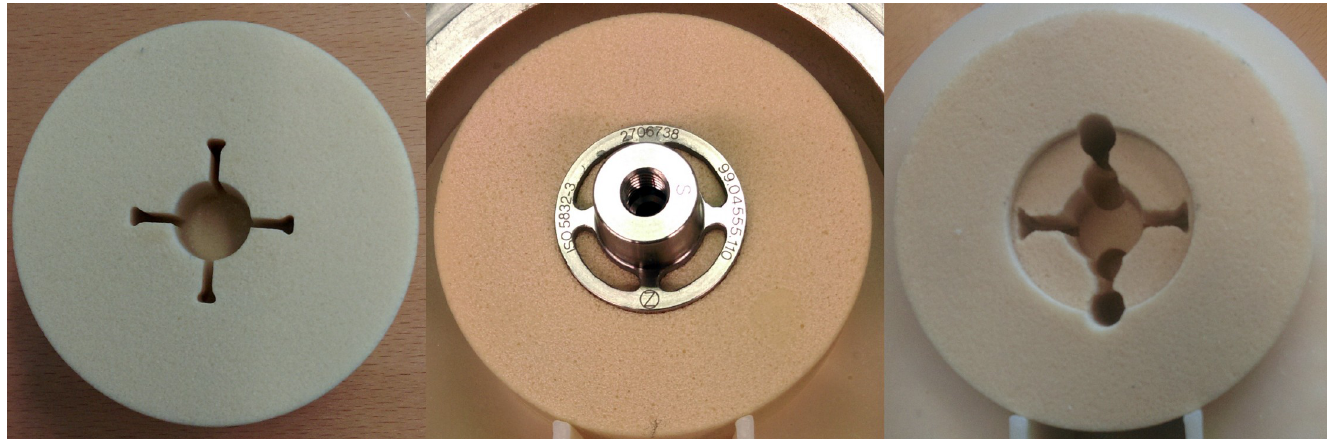
Fig 1. Top view of a bone analog specimen and the machined cavity for the “fixed” condition (left), with implant anchor inserted (middle), and after removal of support material for the “loose” condition.